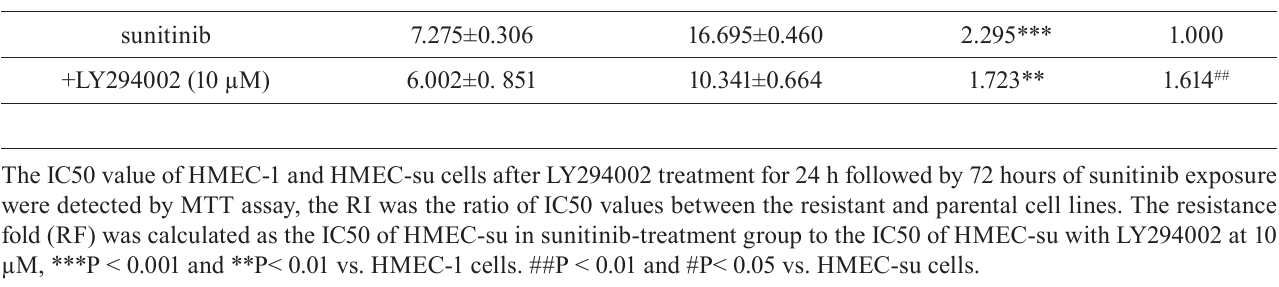
TABLE IV - LY294002 enhances the sensitivity of endothelial cells to sunitinib Agents